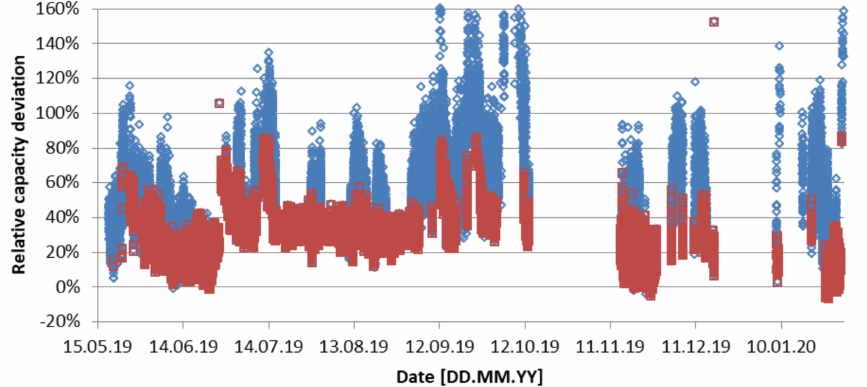
Figure 11. Trend of relative decrease of cooling tower power (calculated minus measured divided by measured) of dataset CT1-Eval2 calibrated with dataset CT2-Cal1; blue dots: all data, red dots: only 100% fan speed.